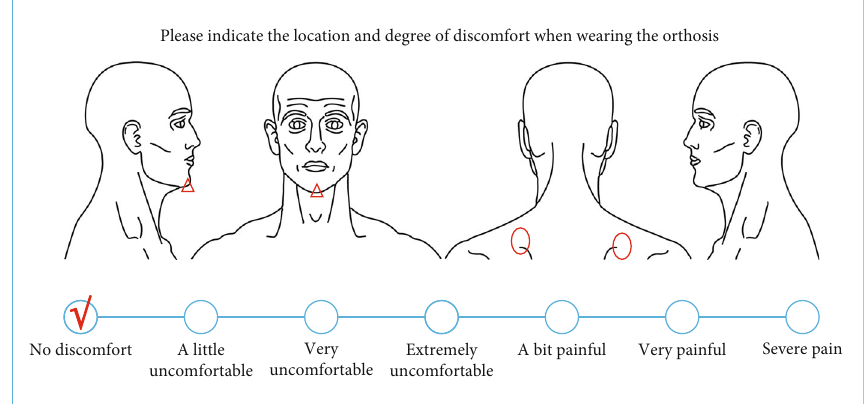
Figure 5: Patient questionnaire chart